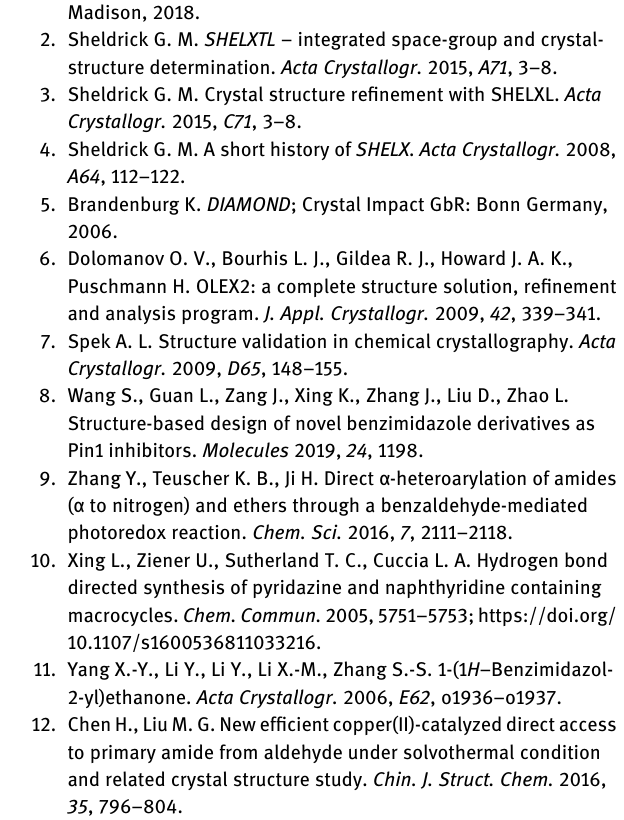
=2.814(2)Å, N 2 ⋯ O 1